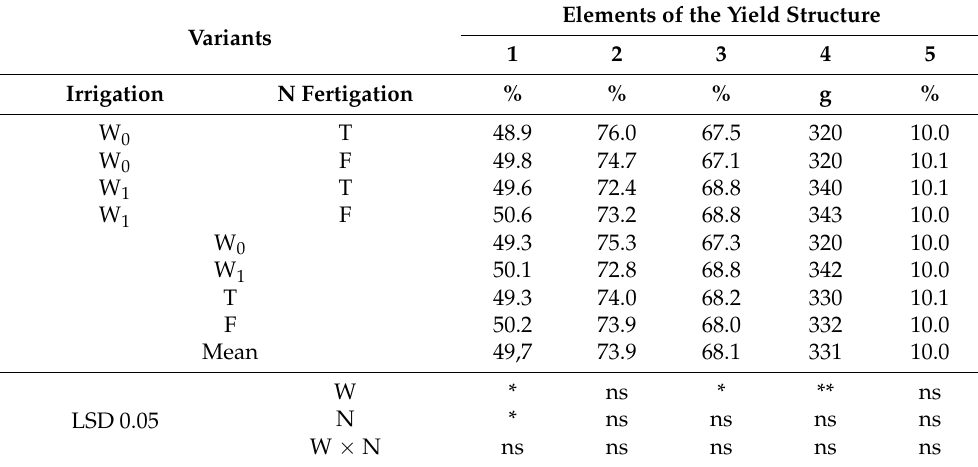
Table 4. Effect of drip irrigation and nitrogen fertigation on selected elements of yield structure and grain quality (average values of 2015–2017) 1—share of cob yield in total crop yield, 2—share of grain yield in cob yield, 3—dry matter content in grain at harvest, 4—thousand-grain weight, 5—protein content in grain.